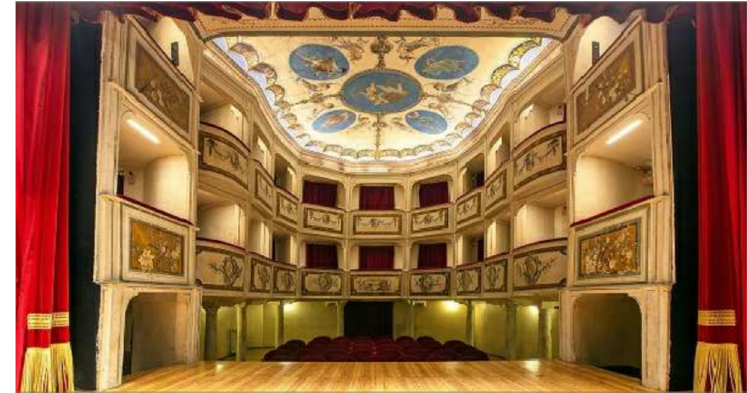
Figure 4. View of the main hall from the stage [1].